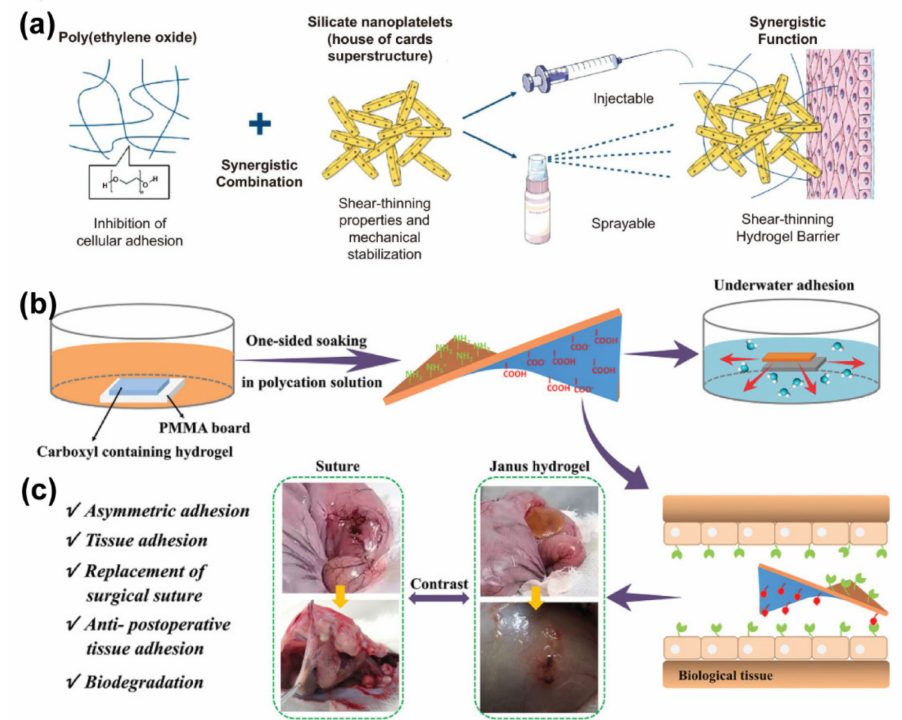
Figure 2. Some samples of ionic–electrostatic crosslinked hydrogels. ( a ) Schematic representation of the sprayable shear-thinning hydrogel barrier formulation and delivery methods. Reprinted with permission from Ref. [158]. Copyright 2021 The Author(s). ( b ) Schematic representation of Janus hydrogel formation by gradient polyelectrolyte complexation with application in underwater adhesions and ( c ) Janus hydrogel application in the treatment of gastric perforation in rabbits. Reprinted with permission from Ref. [159]. Copyright 2020 Wiley-VCH